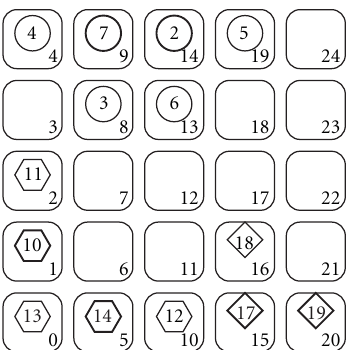
Figure 19: Annealing placement of task graph from Figure 10 on a 5 × 5